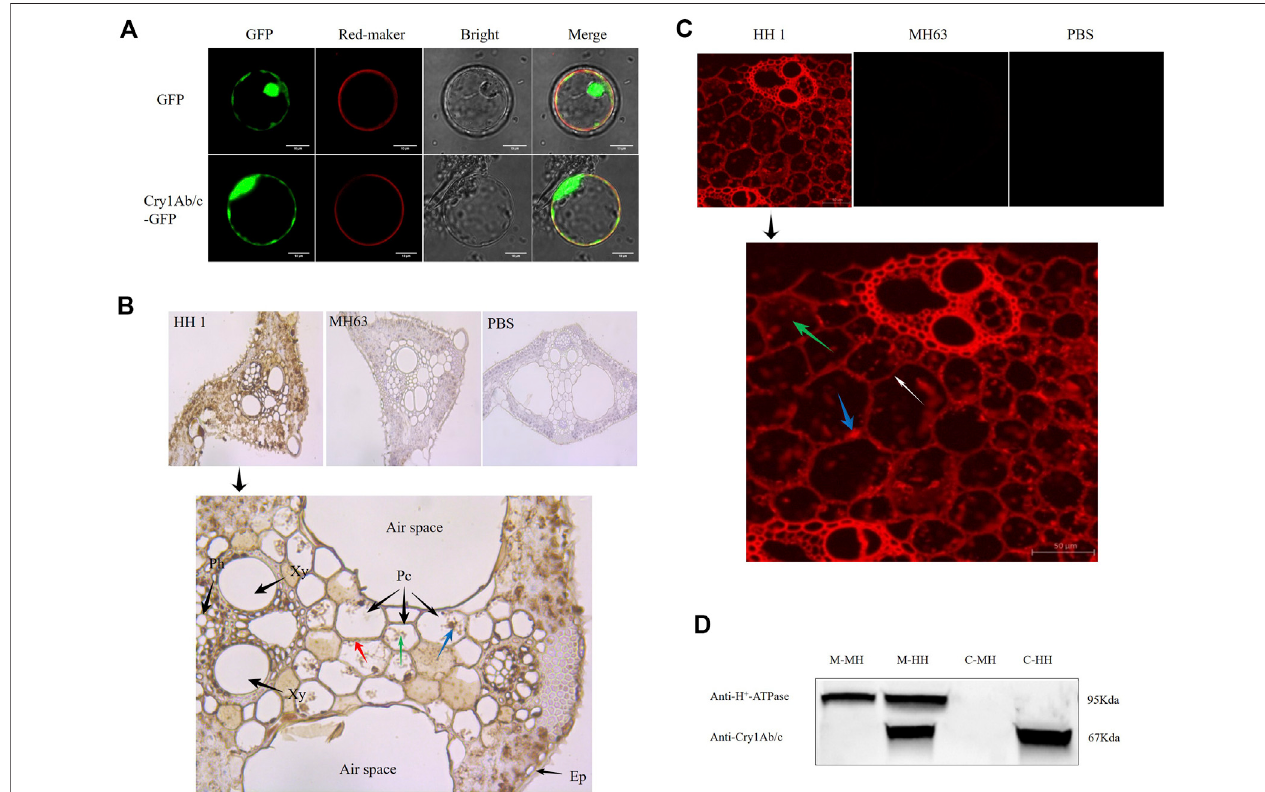
FIGURE 1 | Cellular distribution of exogenous Cry1Ab/c protein in rice plant cells. (A) , Coexpression of Cry1Ab/c-GFP and red membrane-marker in rice protoplasts (scale bar: 10 μ m). Coexpression of empty vector GFP and red membrane-marker was used as a negative control. (B) , Immunohistochemical analysis of exogenousCry1Ab/cproteininmesophyllcellsoftransgenicriceHH1(Crosssectionsofriceleaf),asindicatedbythepresenceofbrown-yellowparticles(DABstaining). Ep, epidermis; Pc, Parenchyma cell; Xy, Xylem; Ph, Phloem. blue arrows indicate nuclei (hematoxylin), green arrows indicate cytoplasm, and red arrows indicate plasma membranes. MH63 rice and PBS were used as negative controls for protein expression and staining, respectively. (C) , Immuno fl uorescence analysis of exogenous Cry1Ab/c protein in mesophyll cells of transgenic rice HH1 (cross sections of rice leaf), as indicated by the red fl uorescent signal. Leaf samples were incubated with an anti-Cry1Ab/c monoclonal antibody and a secondary antibody conjugated to the red- fl uorescent Alexa Fluor 594 dye. White arrows indicate plasma membranes,greenarrowsindicatecytoplasm,andbluearrowsindicatenuclearmaterial.MH63riceandPBSwereusedasnegativecontrols,respectively. (D) ,Western blot analysis of Cry1Ab/c protein in the plasma membrane and cytoplasm of rice plants. Membrane and cytosolic proteins (20 μ g) from leaves of HH1 and MH63 were subjected for western blotting. C-MH, cytosolic protein fraction in MH63; C-HH, cytosolic protein fraction in HH1; M-MH, membrane protein fraction in MH63; M-HH, membrane protein fraction in HH. H + -ATPase was included in the analysis as a membrane indicator (about 95 KDa). The assay was repeated three